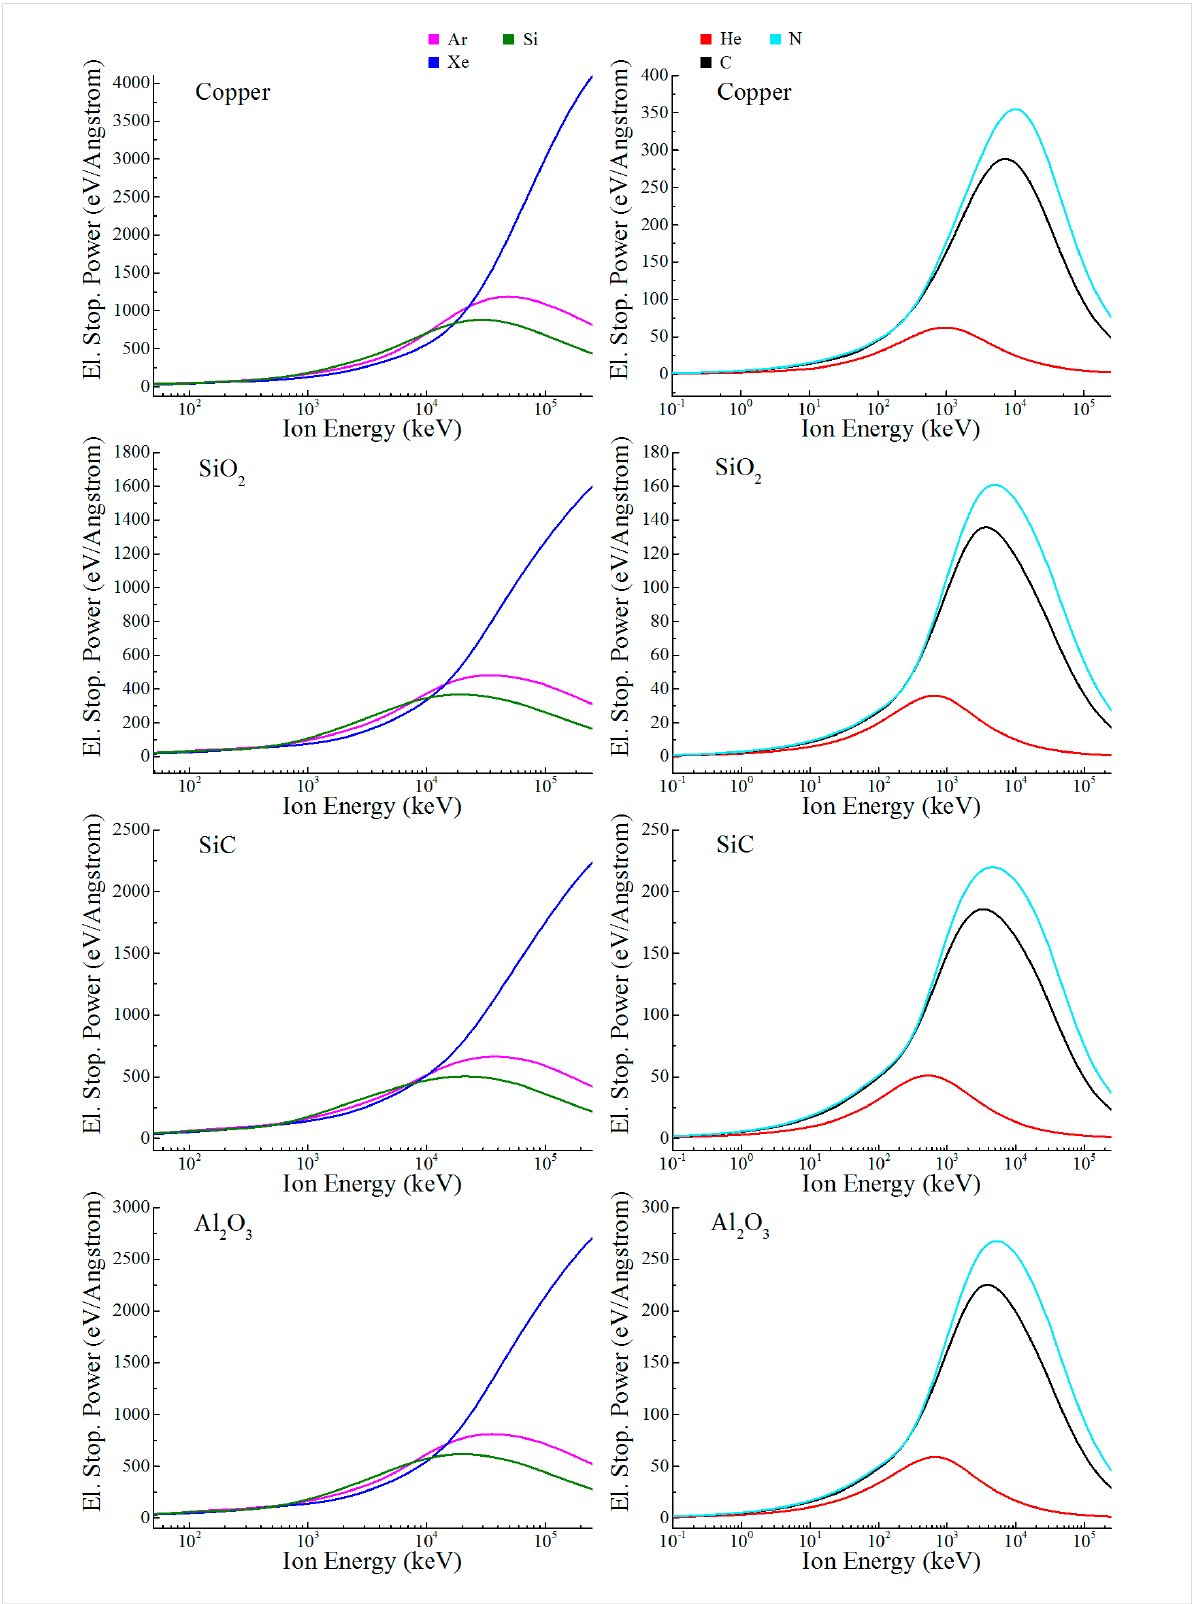
Figure 2: Electronic stopping power dependence on the incident ion energy for Cu, SiO 2 , SiC and Al 2 O 3 substrates and He, Ar, Xe, C, N and Si